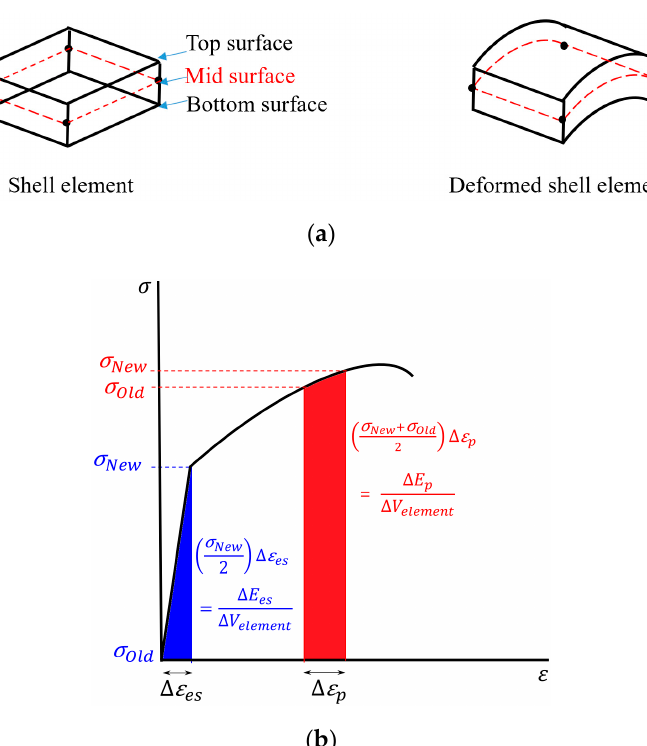
Figure 7. Shell element and energy absorption of the stress–strain curve per element volume: ( a ) element deformation; ( b ) elastic strain energy and plastic deformation energy.